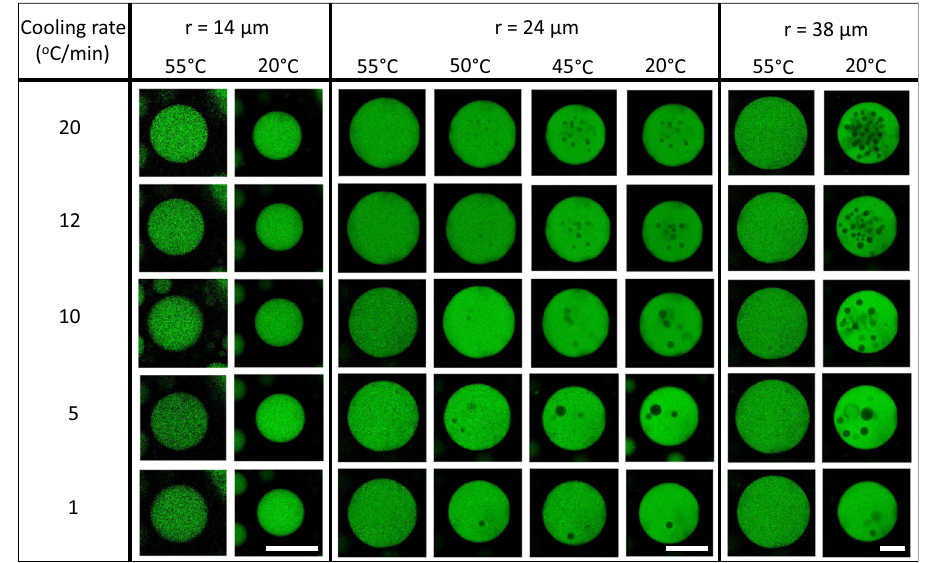
Fig.2|Formationoftrappeddropletsdependsoncoolingrateandcondensate size. Confocalmicroscopyimagesofcondensates,witharadiusof14,24and38 μ m at 55°C, being cooled from 55 to 20°C at different rates. The number of liquids